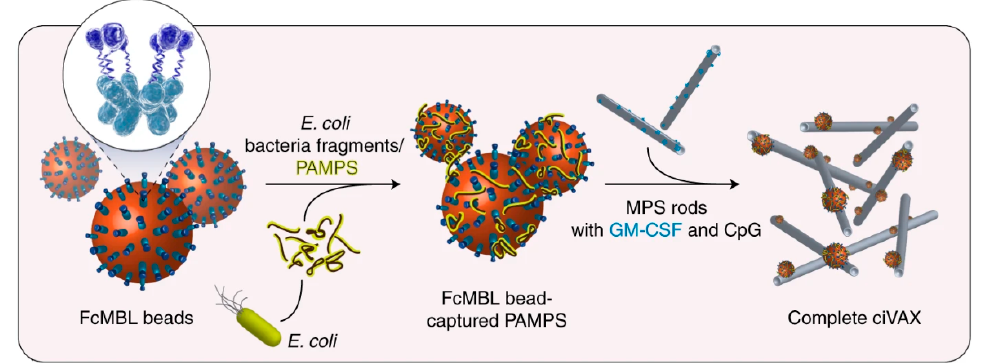
Figure 1. Formulation of ciVAX from E. coli lysate. Adapted and reprinted by permission from Springer Nature, Nature Biomedical Engineering [104]. Copyright 2021.